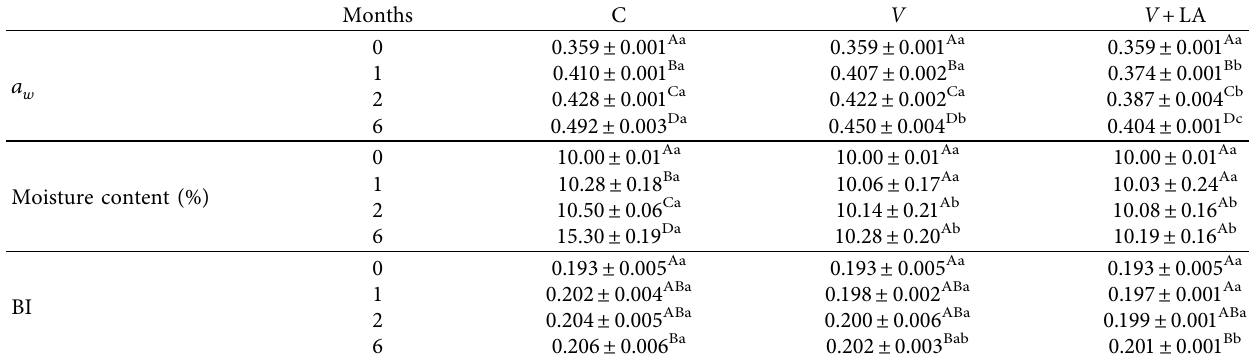
Table 1: Changes in a w , moisture content, and BI of dried peppers during